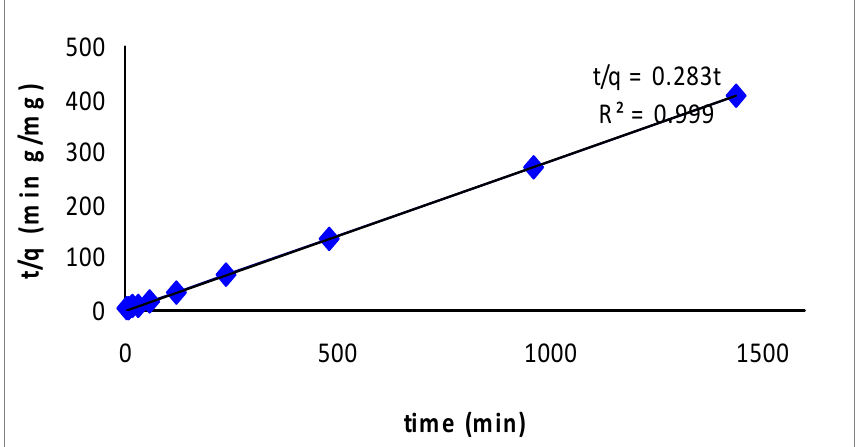
Figure 6. Second order kinetic plot for adsorption of 2,4-dinitrophenol by MIP.